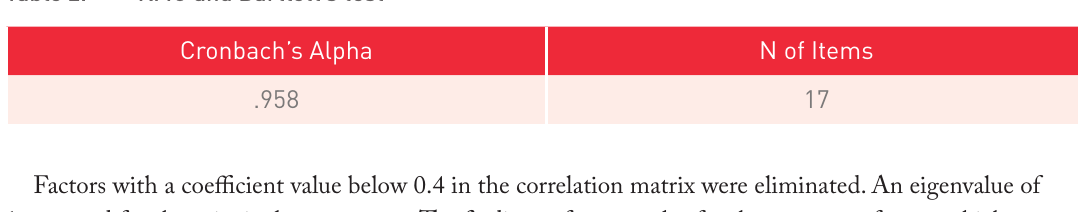
Table 2. KMO and Bartlett’s